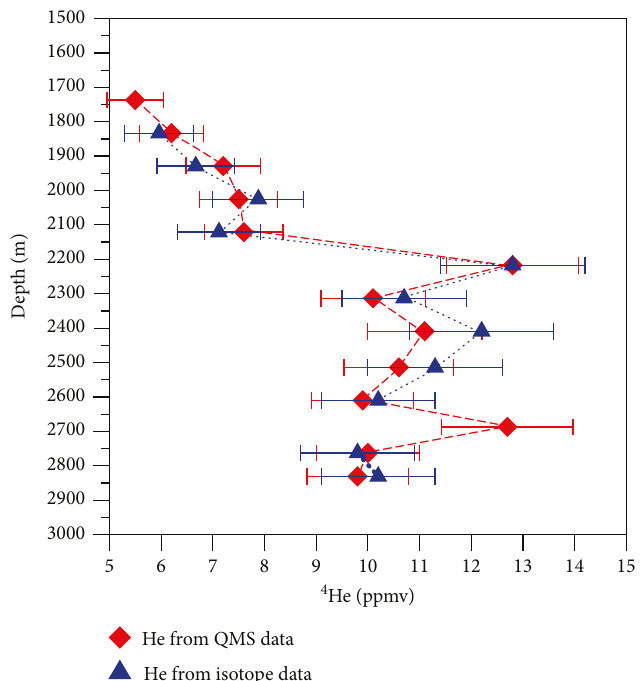
Figure 6: 4 He depth pro fi les from QMS measurements (red) and noble gas isotope analysis (blue) of gas samples collected during water fl ushing after core run 7/8. Error bars indicating uncertainty in the measurement are also shown. Samples from 1737 m and 2687 m depths were not analysed for noble gas